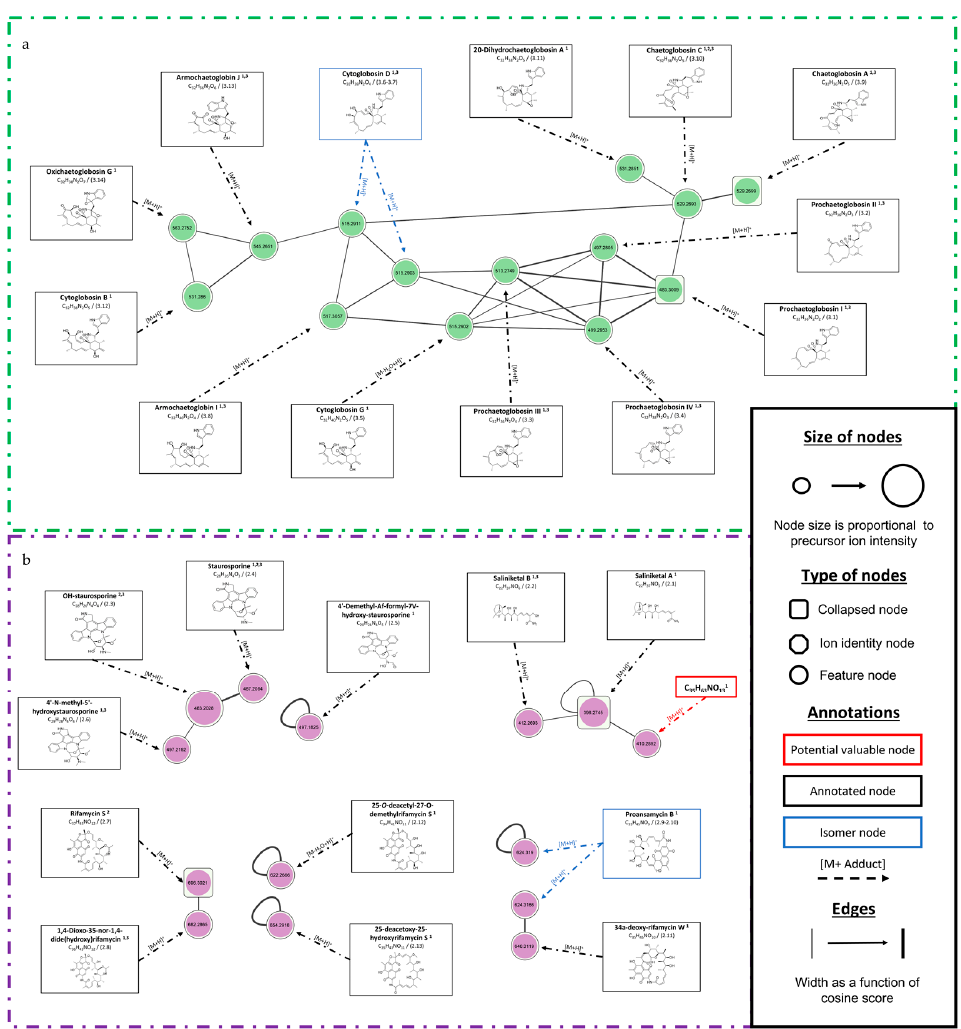
Figure 4. Annotated clusters from the microbial extracts of ( a ) Chaetomium globosum SH-123 and ( b ) Salinispora arenicola SH-78. Superscript numbers in the annotations correspond to data from 1 SIRIUS, 2 GNPS or 3 ISDB timaR bioinformatics tools. (Figure is in high definition, with the possibility of zooming-in)